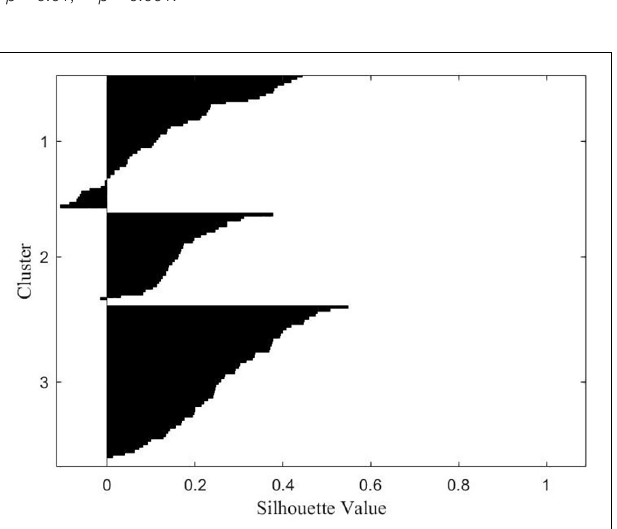
FIGURE 1 | Silhouette plot for the three-cluster